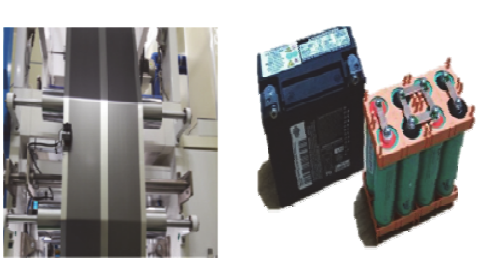
<Figure 12> Electronic Components for Secondary Batteries and Auxiliary Battery for Electronic Cars